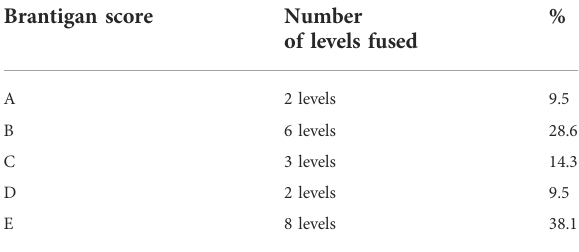
TABLE 3 Evaluation of the fusion status according to the Brantigan score in the presence of SintLife. Brantigan score